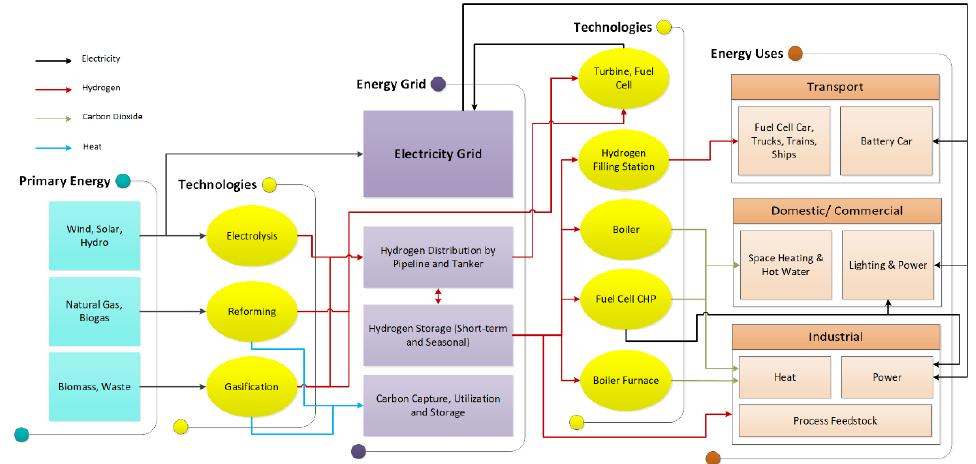
Figure 7. The hydrogen in future energy